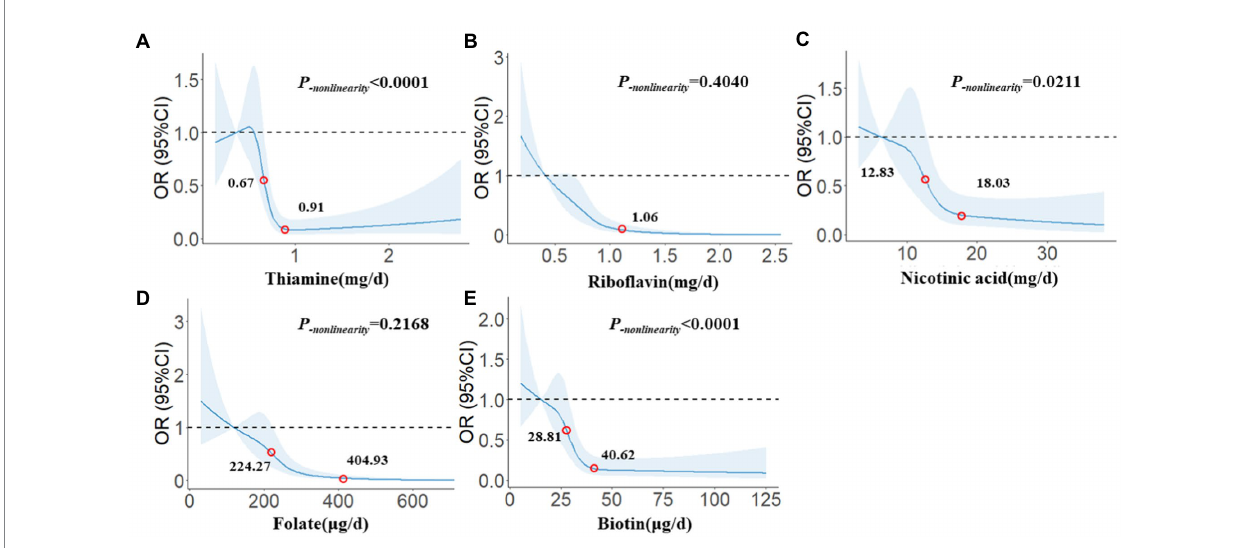
FIGURE 2 The restricted cubic spline for the associations between B vitamins and glioma. The lines represent adjusted odds ratios based on restricted cubic splines for the intake in the regression model. Knots were placed at the 20th, 40th, 60th, and 80th percentiles of the B vitamins intake, and the reference value was set at the 10th percentile. The adjusted factors were the same as in Model 2. (A) Thiamine, (B) Riboflavin, (C) Nicotinic acid, (D) Folate, (E)